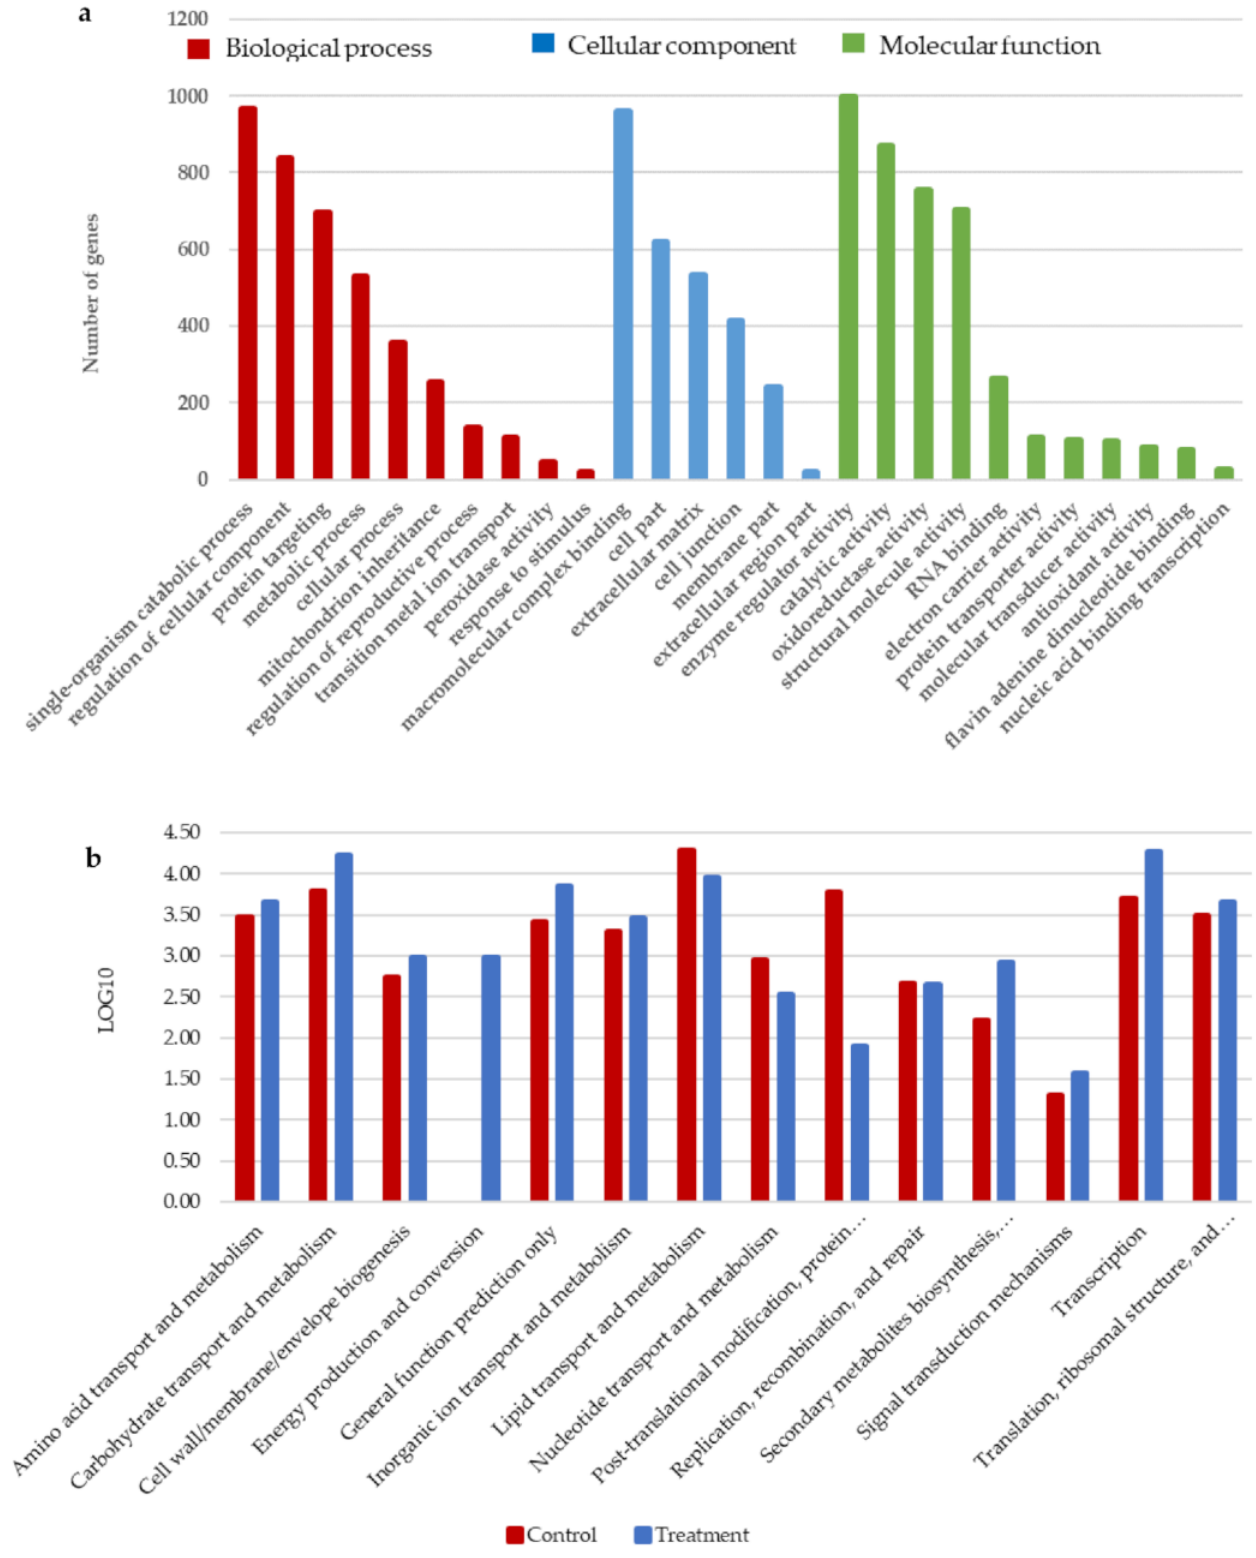
Figure 5. Functional categorization as ( a ) gene ontology (GO) and ( b ) EggNOG of genes differentially expressed under the azo dye Acid Blue 113 induction (treatment)